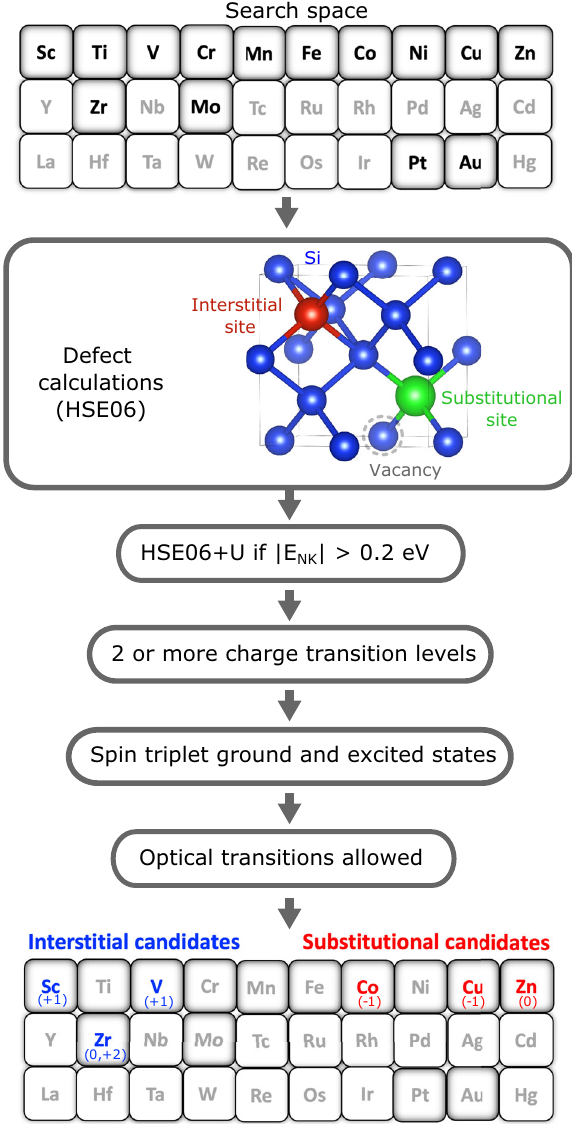
Fig. 1 Work fl ow adopted in our search for transition metal impurities in crystalline Si. The search space consists of all 3 d and select 4 d and 5 d transition metals (shown at the top). Defect calculations then enable reducing the set using various search criteria, leading to the identi fi cation of 7 candidate impurities as interstitials and substitutional defects (shown at the bottom with speci fi c charge state). E NK is the non-Koopmans' energy and characterizes the deviation from generalized Koopmans'